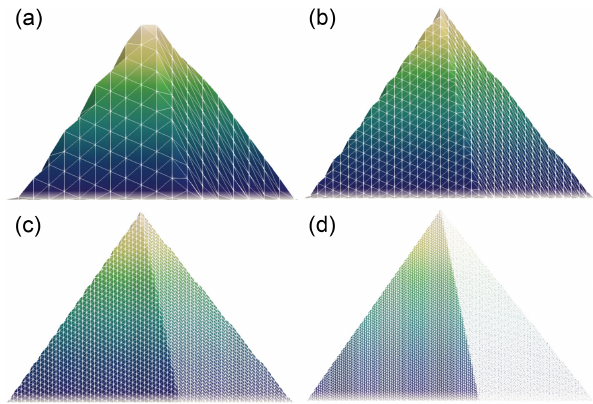
Figure 4. Initial pyramid geometry from left to right for mesh res- olutions N = 125 , 250 , 500 , 1000 to visualise the quality of feature representation on these meshes.